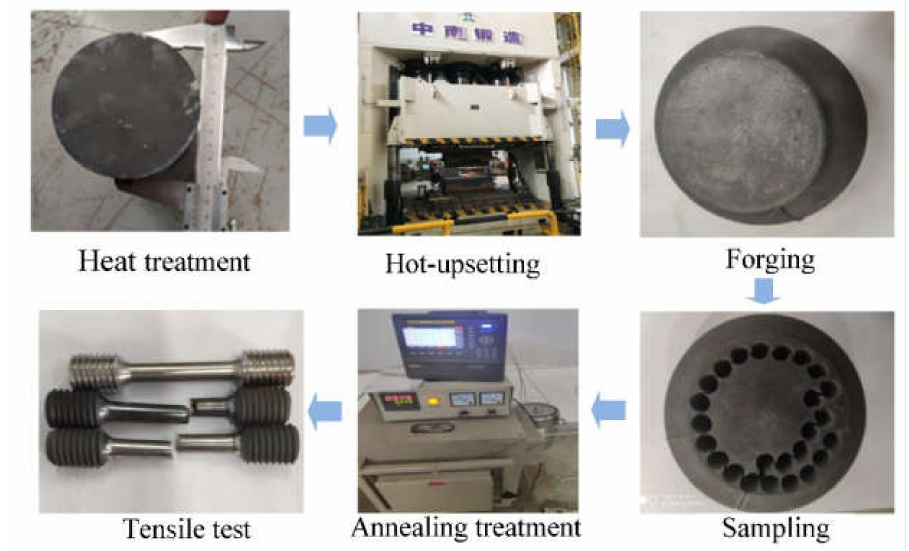
Figure 2. Experimental procedure diagram for the whole